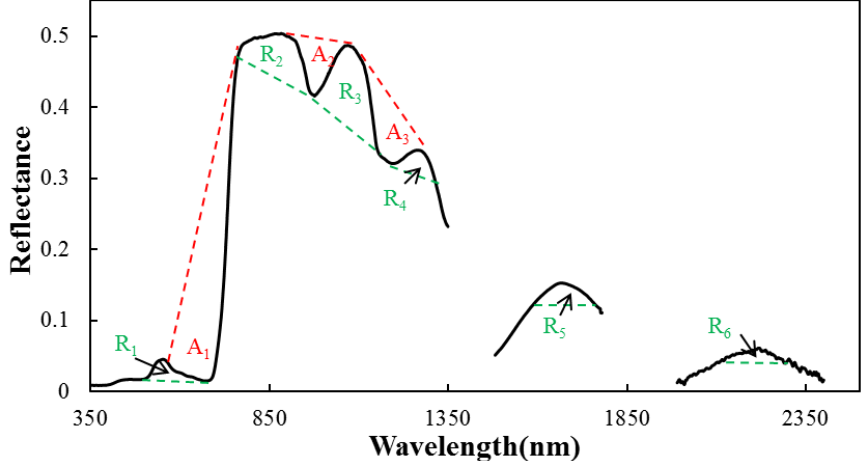
Figure 1. Three absorption (A) and six reflectance (R) characteristics of the wheat canopy